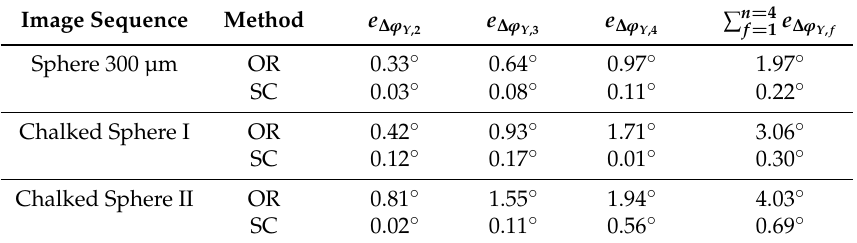
Table 5. Deviations of the estimated tilt angles to the expected manually set stage angles for the image sequences in that the results of the orthographic and scaled orthographic factorization methods differed is defined as | ∆ ϕ Y , f − 5 ◦ | . significantly. e ∆ ϕ Y , f